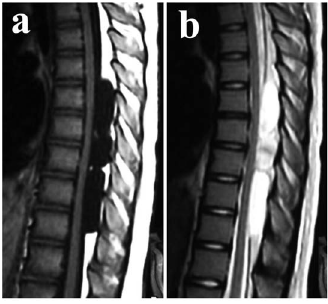
Figure 1. Spinal extradural arachnoid cyst. T1- (a) and T2- (b) weighted sagittal plane images of MRI (magnetic resonance imaging) scan. Subject III-2 of Family 1, 13 years old. There are multiple cysts dorsal to the spinal cord at the thoracolumbar